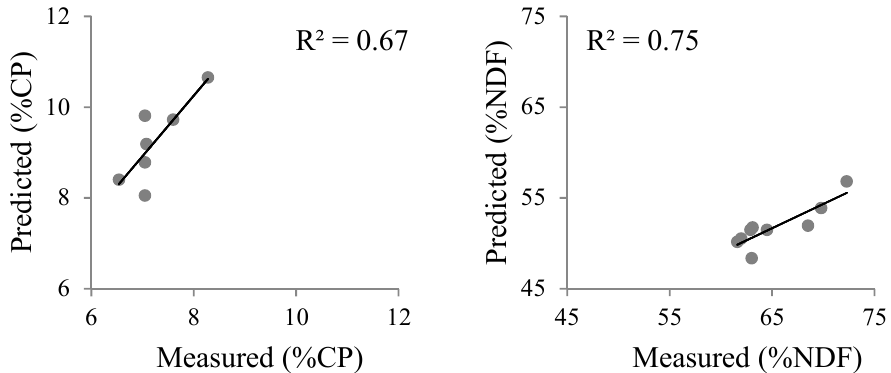
Figure 5. Measured vs. predicted values of chemical data, using the selected best model applied on field measurements. Note a larger bias in the estimation of NDF.